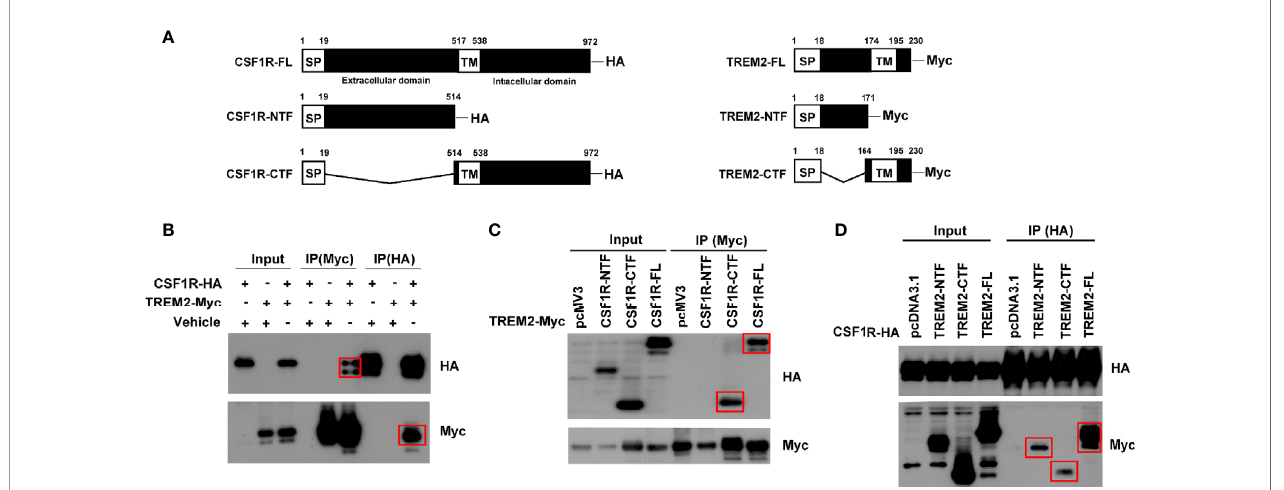
FIGURE 1 | TREM2 interacts with CSF1R. HEK293T cells were transfected with different combinations of indicated plasmids, and Western blotting was performed using HA and Myc-tag antibodies. (A) Schematic diagram of fragments of CSF1R and TREM2. (B) Co-IP of HA-tagged full-length CSF1R with Myc-tagged full-length TREM2. (C) Co-IP of HA-tagged CSF1R fragments with Myc-tagged full-length TREM2. (D) Co-IP of HA-tagged full-length CSF1R with Myc-tagged TREM2 fragments. Red rectangles indicate positive